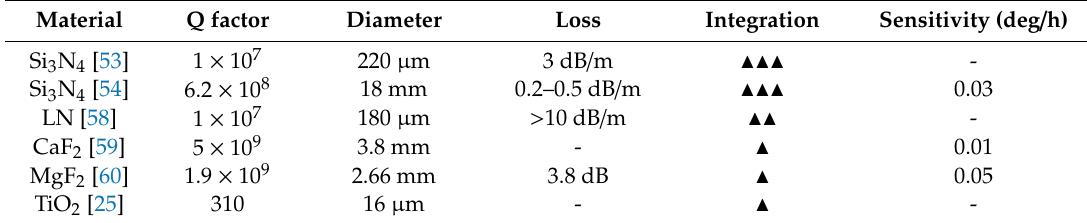
Table 2. Basic features of high quality factor (Q)